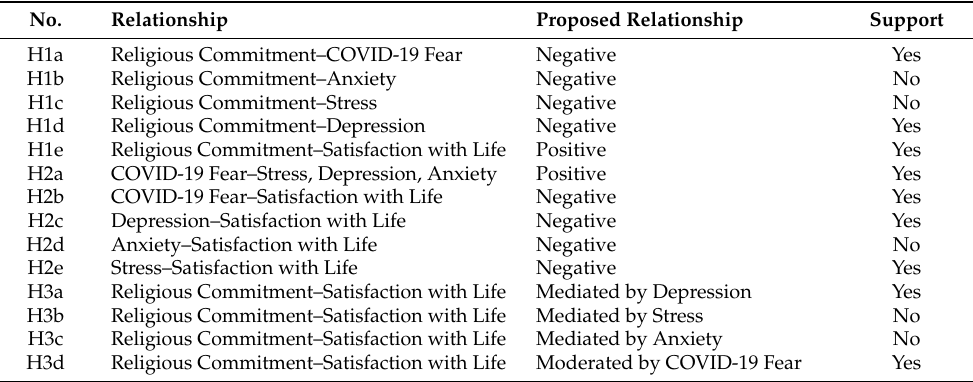
Table 6. Summary of hypotheses testing